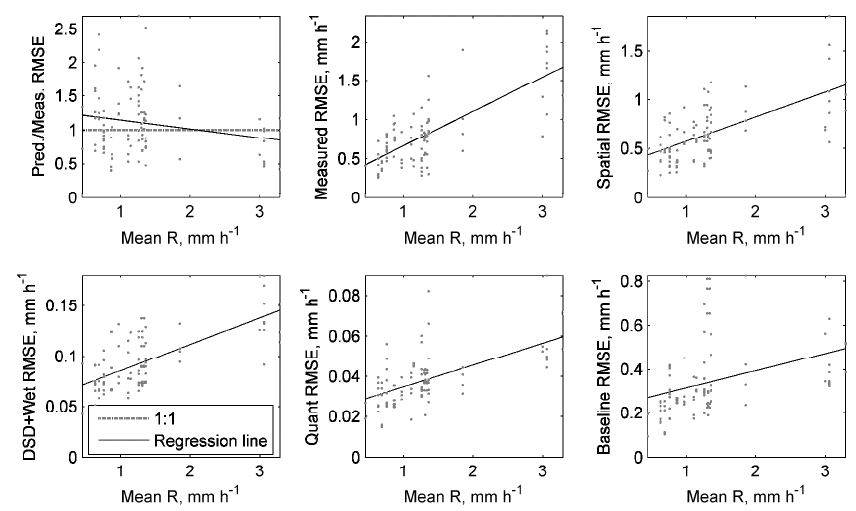
Fig. 12. Performance statistics S j , j =1,..,96 (Eq. 50) for total predicted error, measured errors and various errors sources (spatial variability, DSD and wet antenna, quantization and baseline), as a function of rain rate recorded by a nearby rain gauge, ∆ t = 60 minutes.